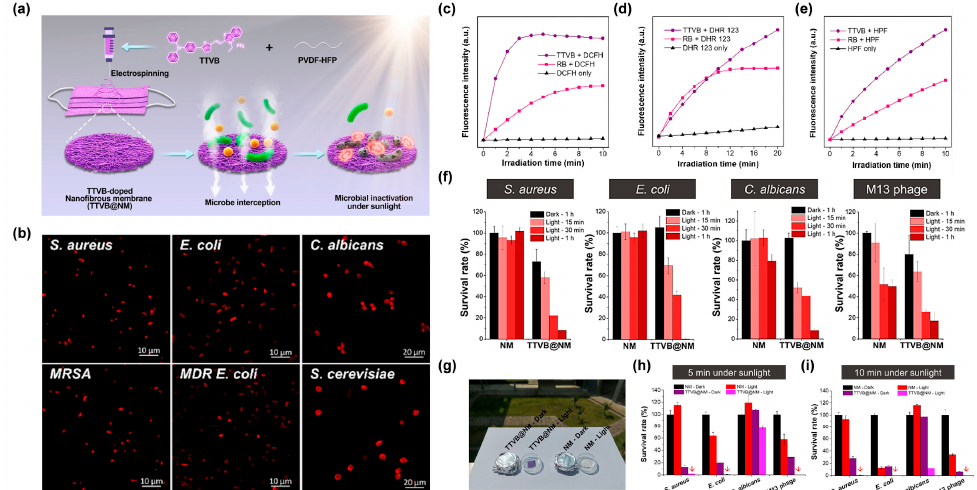
Figure 9. ( a ) Diagram of the preparation of TTVB@NM for antimicrobial applications. ( b ) CLSM imaging of bacteria and fungi co-incubated with TTVB. Relative fluorescence intensity of ( c ) DCFH for total ROS detection, ( d ) DHR123 for O 2• − detection, and ( e ) HPF for OH • detection of TTVB and RB under light irradiation (34 mW/cm 2 ). ( f ) Microbial survival rate treated with NM or TTVB@NM in dark or under sunlight irradiation. ( g ) Antimicrobial experiment against pathogenic aerosols in dark or under sunlight irradiation. Survival rate of microbes under sunlight irradiation for ( h ) 5 min and ( i ) 10 min. Reprinted with permission from [77], copyright 2021, Elsevier.